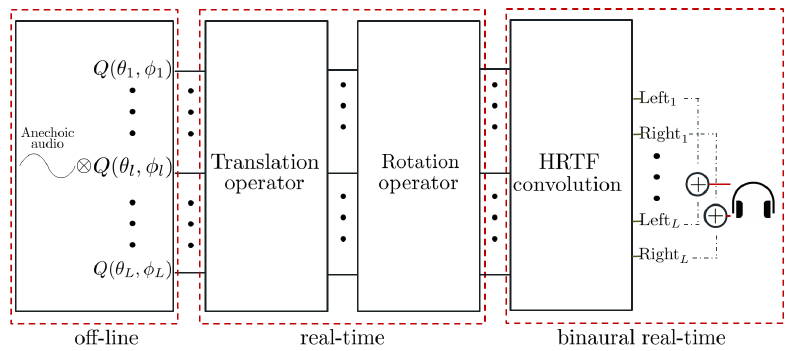
Figure 15. General architecture for a real-time auralization based on the plane wave